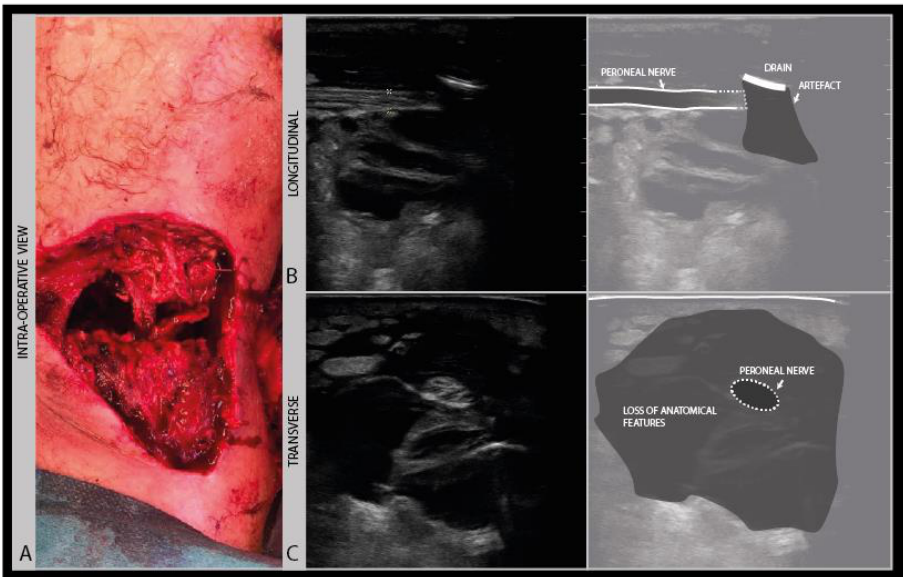
Figure 11. Severe knee torsion injury with a large tissue defect ( A ): post-surgical debridement ultrasound image of the posterior knee, with a tissue drain artefact obscuring the view of the underlying peroneal nerve ( B ) and a loss of anatomical features ( C ).